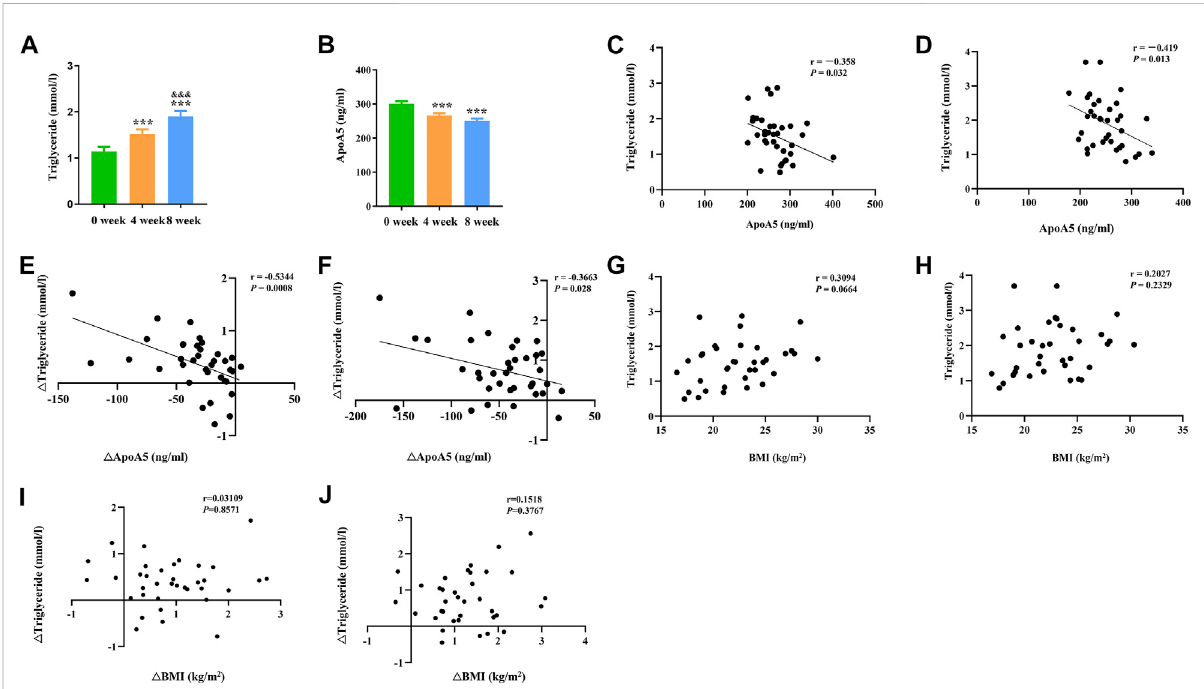
FIGURE 1 Reduction of plasma apoA5 levels contributed to olanzapine-induced hypertriglyceridemia in schizophrenia patients. (A) Plasma triglyceride and (B) apoA5 levels in schizophrenia patients. Plasma apoA5 levels correlated with alterations in plasma triglyceride levels after 4-week (C) and 8- week (D) treatmentofolanzapine.ChangesinplasmaapoA5levelscorrelatedwithalterationsinplasmaTGlevelsatweek4 (E) andweek8 (F) .Results of correlation analyses between BMI and plasma triglyceride levels at week 4 (G) and week 8 (H) . Results of correlation analyses between changes in BMI and changes in plasma triglyceride levels at week 4 (I) and week 8 (J) . Results are shown as the mean ± SEM. BMI: body max index;